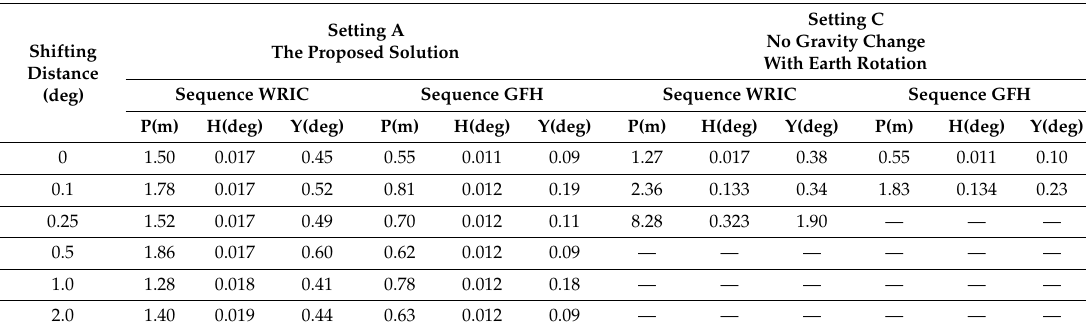
Table 4. The RMSEs of the position, horizontal attitude, and yaw of POS620 under Setting A and Setting C for the